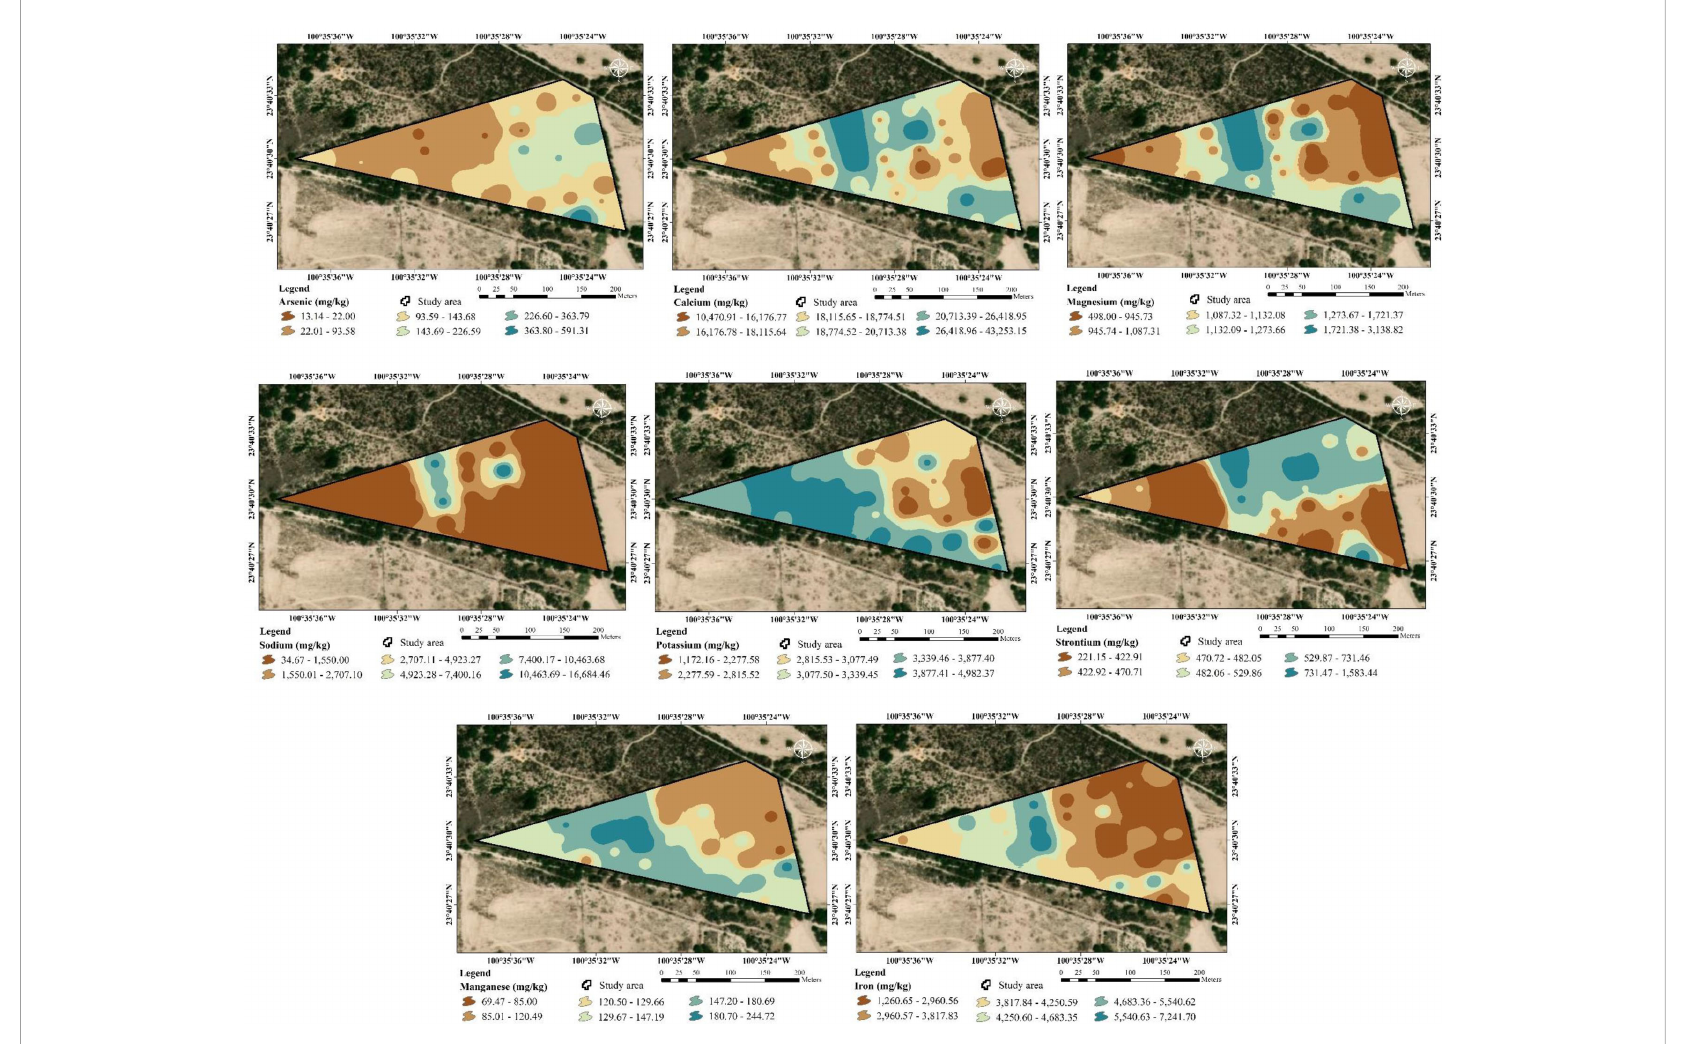
FIGURE 3 Spatial distribution of metal concentrations in the recreational